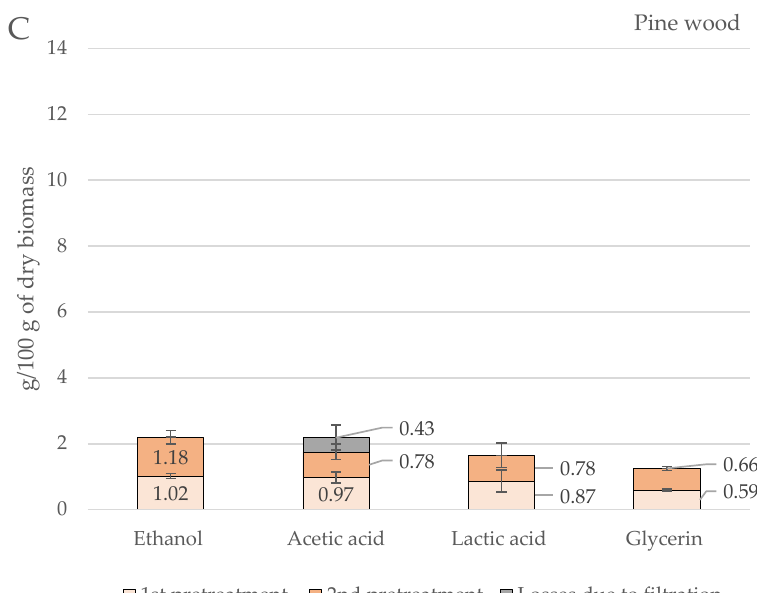
Figure 4. Metabolite yields for ethanol, acetic acid, lactic acid, and glycerin from barley straw ( A ), aspen wood ( B ), and pine wood ( C ) after seven days of fermentation. The figures also show the losses of acetic acid due to filtration after pretreatment. Each value on the graph represents the mean of one colored part of the beam. The corresponding standard deviation is shown as small bars on top of the beams. The legend on figure ( C ) is also used for figures ( A , B ). The lowest metabolite yields were gained from pine wood. This can be explained by the fact that just low amounts of sugars were released after enzymatic hydrolysis. Thus, the metabolite yields were low as well.